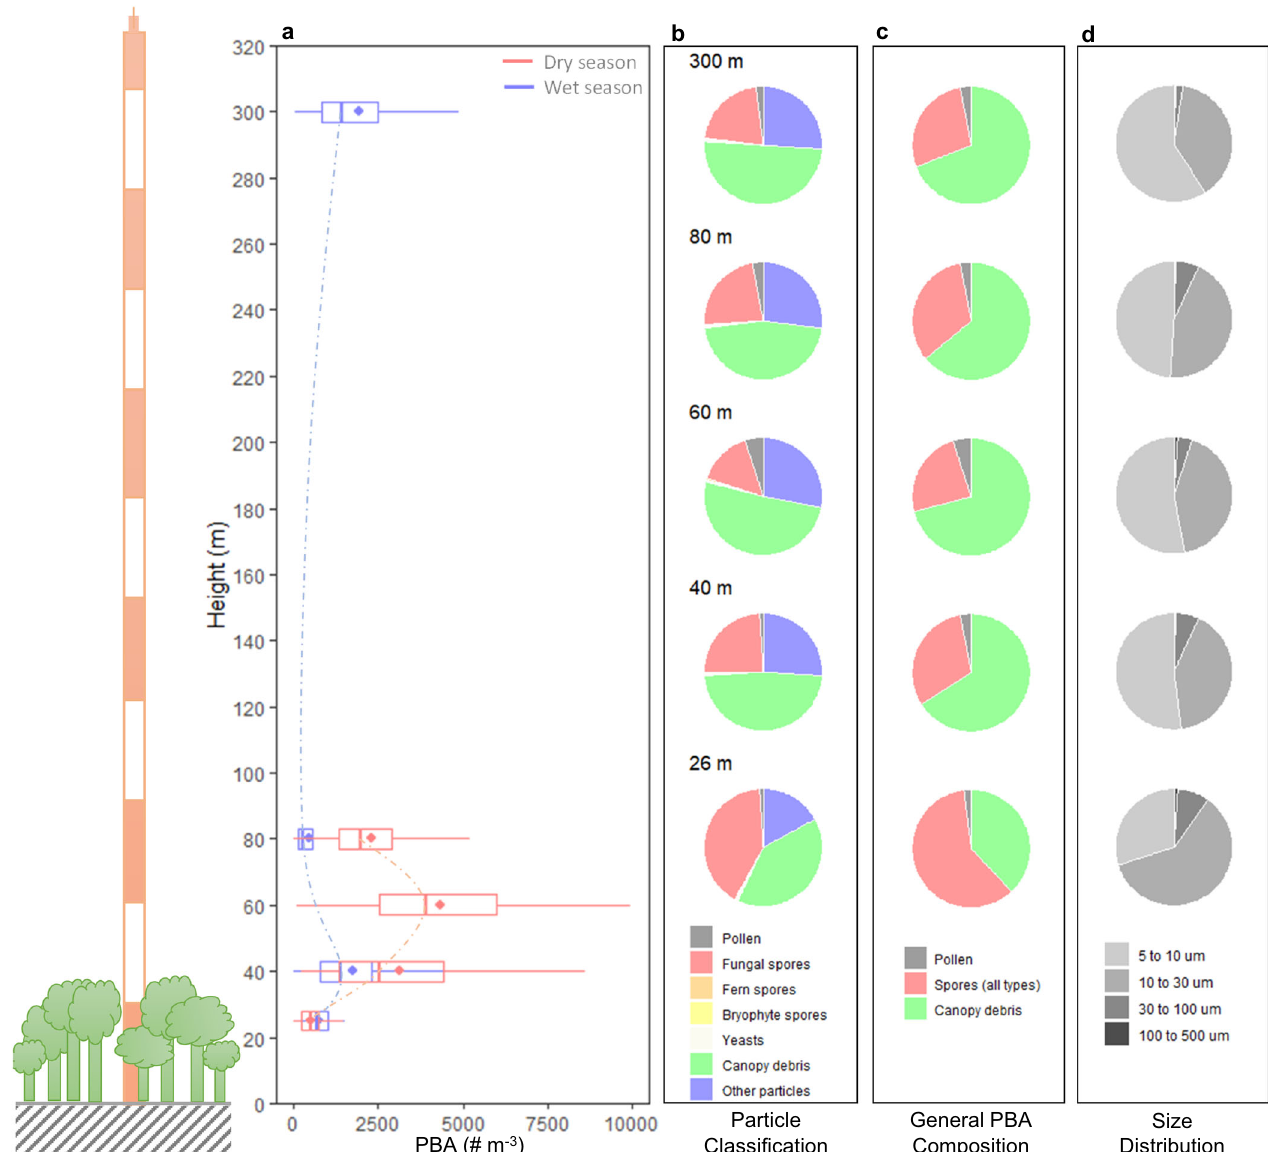
Fig. 1 Vertical distribution and composition of giant PBA. Particles ranging from 5 to 500 µm at 5 different heights above the Amazon rainforest: 26 m, 40 m, 60 m, 80 m, and 300 m. Data at each height are con fi ned to the sampling periods at the respective level (see Table 1). a Seasonal PBA quanti fi cation and general pro fi le. Boxplots with the representation of the box for the 1st and 3rd quartiles, vertical line inside the box shows the median value, while the dot indicates the average value, 5 and 95 percentiles as whiskers. Dry season displayed in red and wet season in blue; b Detailed particle classi fi cation per height with relative contribution of each category as displayed in the legend; c General PBA composition with the following categories merged as spores: fungal spores, fern spores, bryophyte spores, yeasts; d Size distribution of PBA particles from 5 to <10 µm, 10 to <30 µm, 30 to <100 µm, and 100 to 500